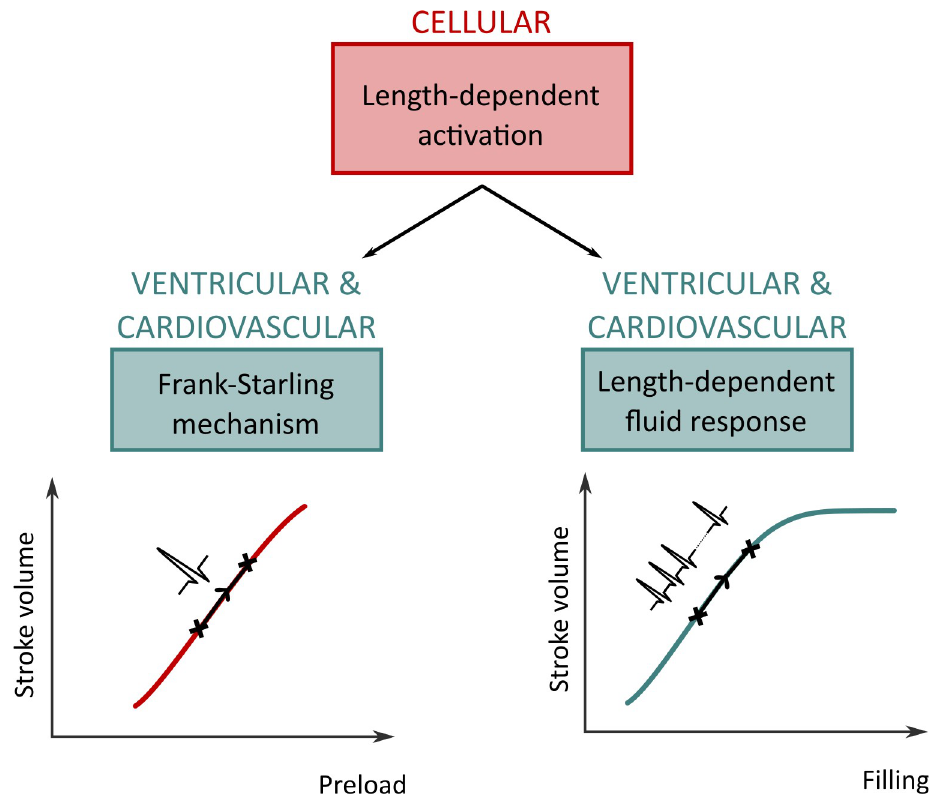
Fig 14. Visual representation of the interplay between the FS mechanism, vascular filling, and LDA. LDA, a cellular property, underlies the FS mechanism. The latter occurs at the organ scale on a beat-to-beat basis. LDA also underlies the motivation for vascular filling therapy. As vascular filling takes place, a new steady state is obtained after several heartbeats and a new stroke volume is achieved. Stroke volume, preload, and filling are variables which also impact or depend on cardiovascular-level variables, such as afterload. Each curve is a qualitative curve, as this figure is built from the qualitative conclusions of our study.